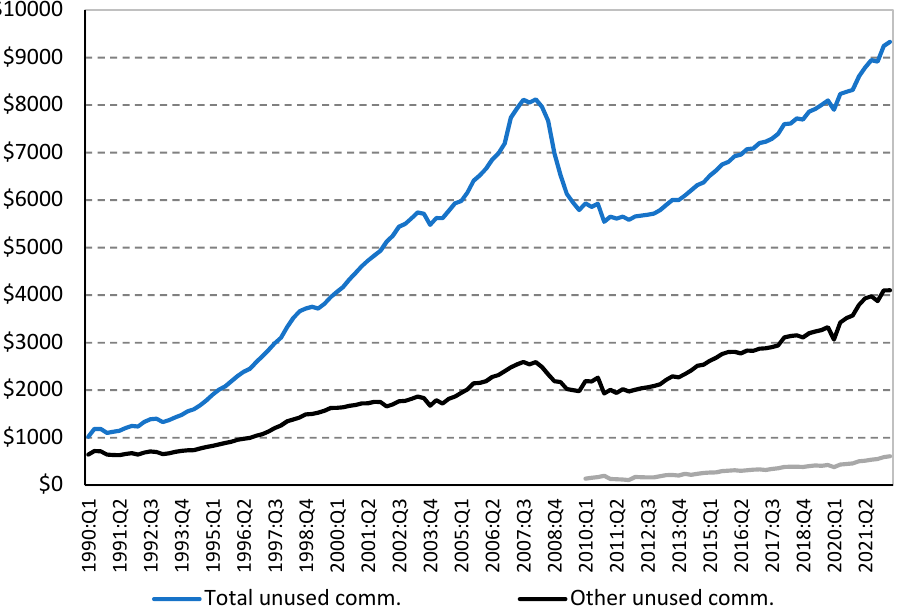
Figure 3. Unused Commitments for U.S.-Chartered Depository Institutions (USD Billions). Source: Federal Reserve. Notes: “Other unused commitments: to financial institutions” is part of “other unused commitments”. The components of “other unused commitments” are only available starting in 2010.